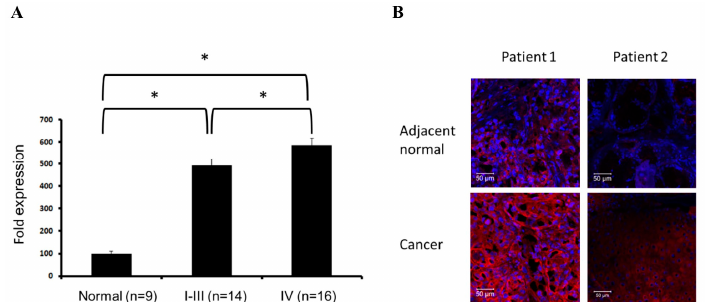
Figure 6. SPARC expression in clinical samples: ( A ) mRNA expression of SPARC in clinical samples. t -test; * p < 0.05, significant difference between two groups and ( B ) immunofluorescent detection of SPARC in frozen sections of tumors and adjacent normal tissue. Antibody staining is red and nuclei are stained with DAPI. Two of seven pairs are shown. Scale bar=50 μ m.